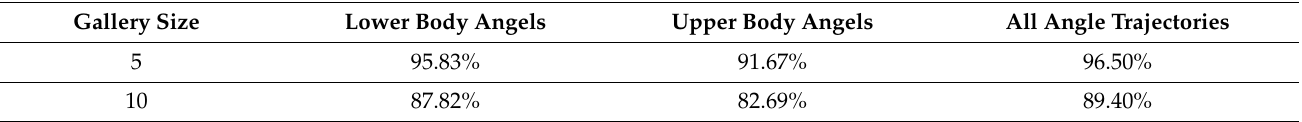
Table 4. Gait classifier recognition rates using various combinations of angle